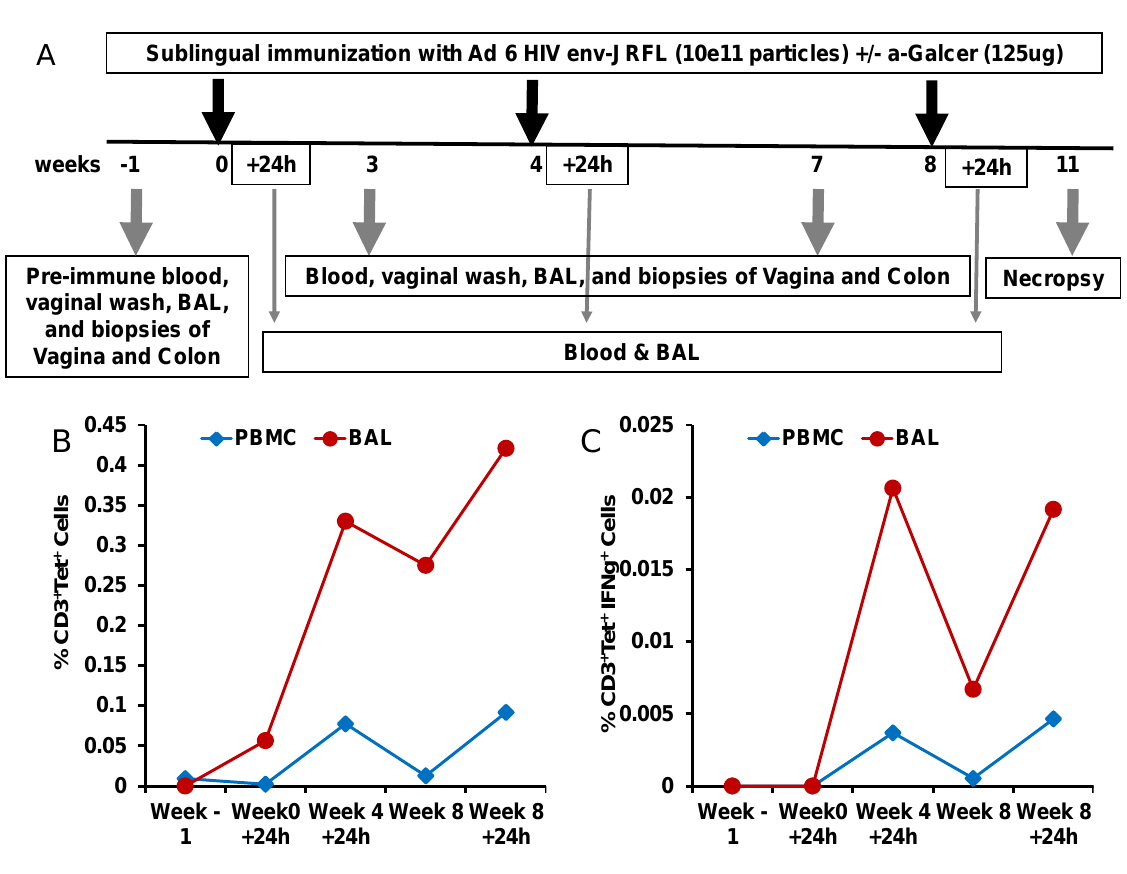
Figure 5. Expansion and activation of NKT cells after sublingual immunization with HD-Ad HIV envelope in the presence of α-GalCer adjuvant: In this pilot study, a single rhesus monkey was immunized by the sublingual route with the HD-Ad vector encoding the HIV-1 envelope protein (10 11 vp) along with α-GalCer (125 µg) as shown in the scheme ( A ). Prior to immunization and at different time points subsequently, blood and bronchial alveolar lavage (BAL) samples were collected and lymphocytes were analyzed by flow cytometry for the percentages of NKT cells in terms of CD3 + , CD1d tetramer + cells ( B ) and percentages of IFN-γ producing NKT cells in terms CD3 + , CD1d tetramer + , IFN-γ + cells ( C